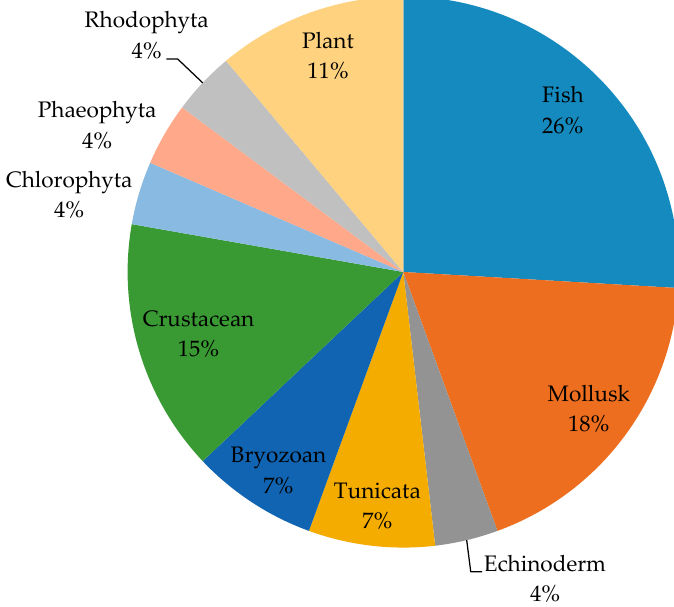
Figure 3. Taxonomic groups of the potential IAS in the Baltic Sea.